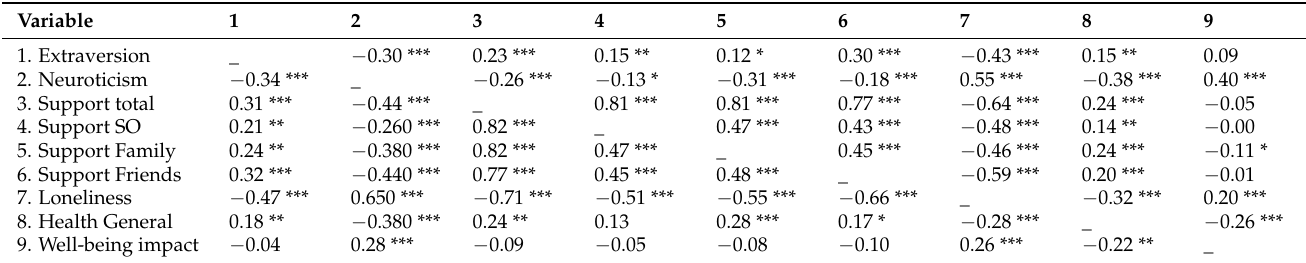
Table 3. Intercorrelations of key study variables disaggregated by